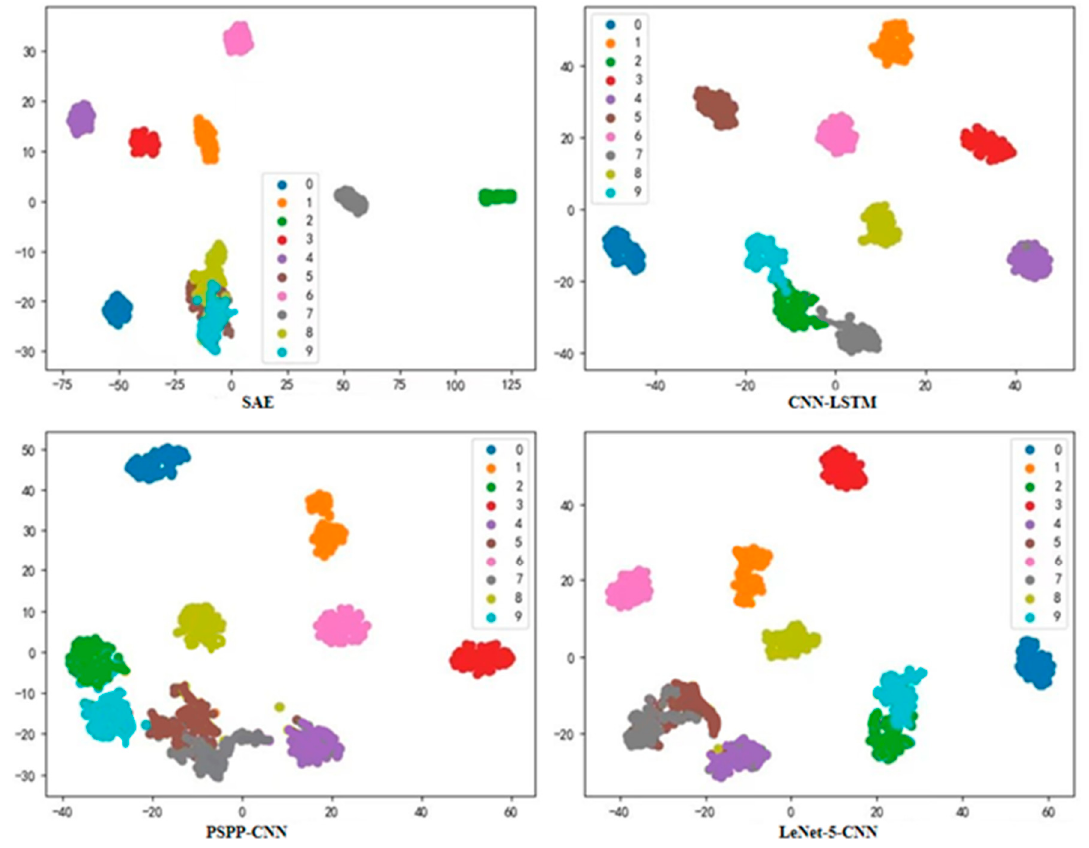
Figure 14. Visualization results of t-SNE in four model tests (for comparison with the proposed model). Table 3. Comparison of the accuracy of the proposed model with other models in rolling bearing fault diagnosis for CWRU.